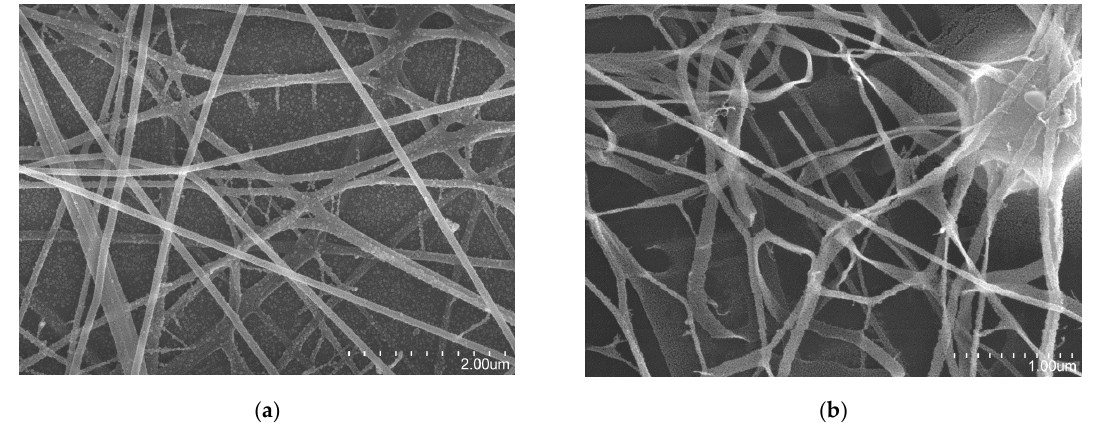
Figure 1. ( a ) SEM image of the pure SnO 2 device; ( b ) SEM image of the graphene (0.01 mg/mL) doped SnO 2